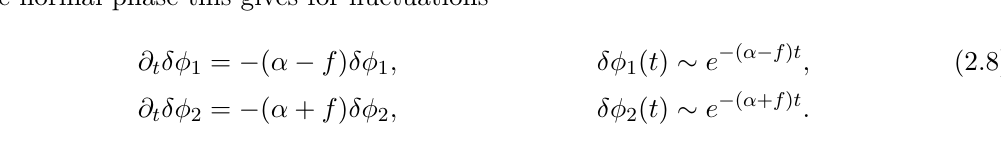
the mode δφ corresponds to the fluctuation 0 1 is the fluctuation of its phase — the Goldstone mode. 2 ). Above T f the degeneracy between → T f c c c the phase mode turns into damped c